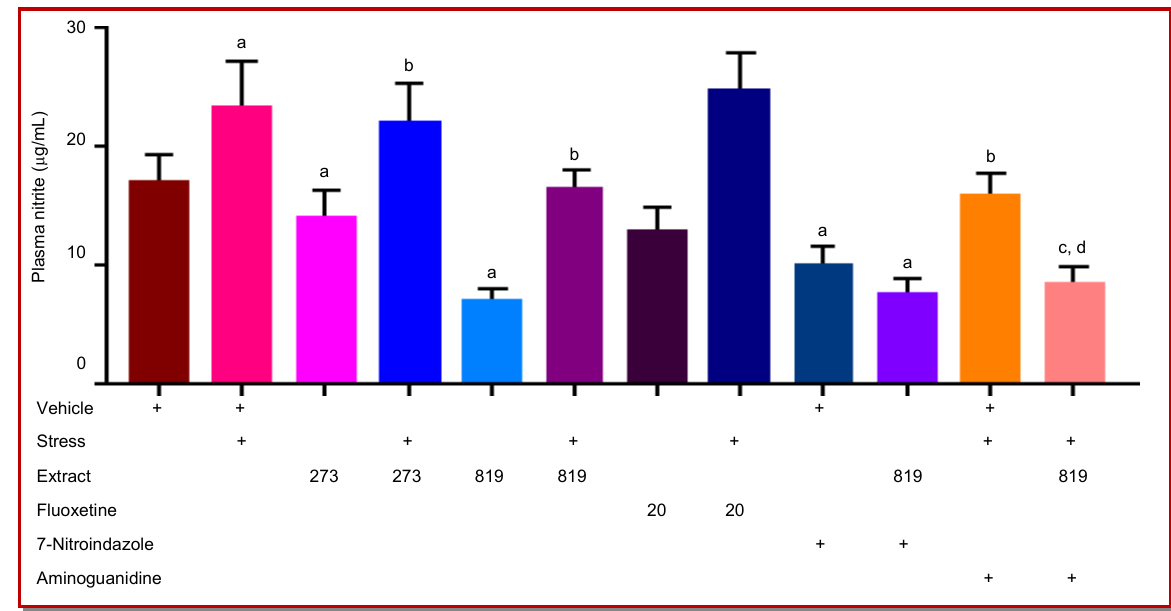
Figure 3: Effect of A. blazei and its combinations with 7-nitroindazole and aminoguanidine on plasma nitrite levels of unstressed and stressed mice. n=6 in each group. Values are expressed as the mean ± SEM. Data were analyzed by one- way ANOVA followed by Tukey’s test, except data for unstressed and stressed mice, which were analysed by Student’s unpaired t -test. a p<0.05, significant difference from vehicle-treated unstressed mice); b p<0.05, significant difference from immobilization-induced stressed mice; c p<0.05, significant difference from A. blazei (819 mg/kg)-treated stressed mice; d p<0.05, significant difference from aminoguanidine-treated stressed